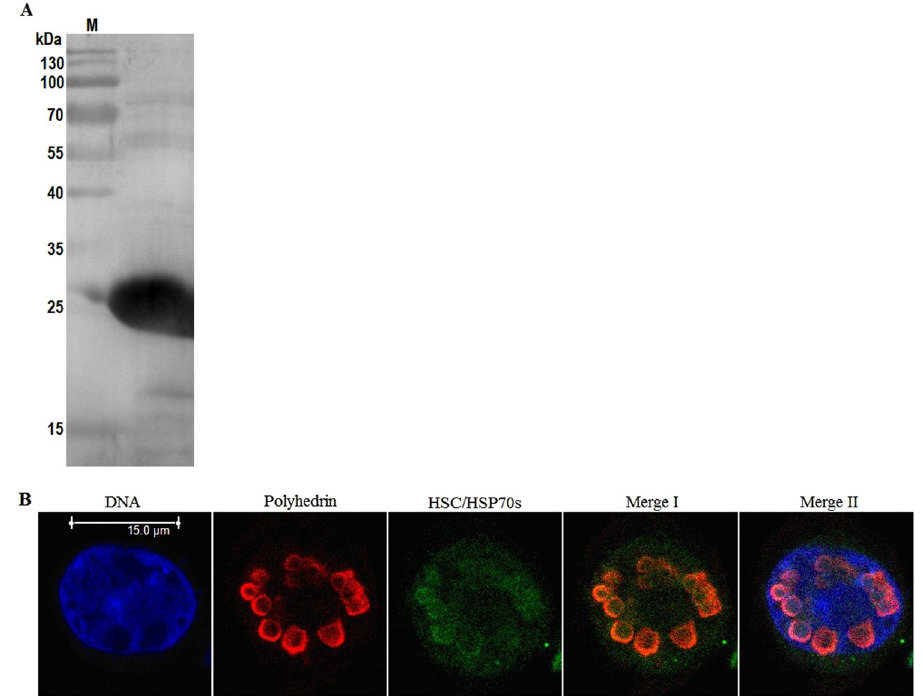
Figure 2. Host protein HSP70-4 was associated with the BmNPV polyhedra matrix. ( A ) Western blot analysis of HSP70-4 in the BmNPV polyhedra matrix. The fraction over the upper sucrose gradient was loaded for the Western blot analysis. Images were visualized using a chemiluminescence detection system. Lane M, the protein marker. ( B ) Co-localization of polyhedrin with HSP70-4 in the polyhedra in infected BmN cells. Cells were infected with the BmNPV T3 isolate at an MOI of 10 TCID 50 /cell. At 48 h p.i. the cells were fixed, permeabilized, and then incubated in a buffer containing mouse monoclonal anti-polyhedrin and rabbit polyclonal